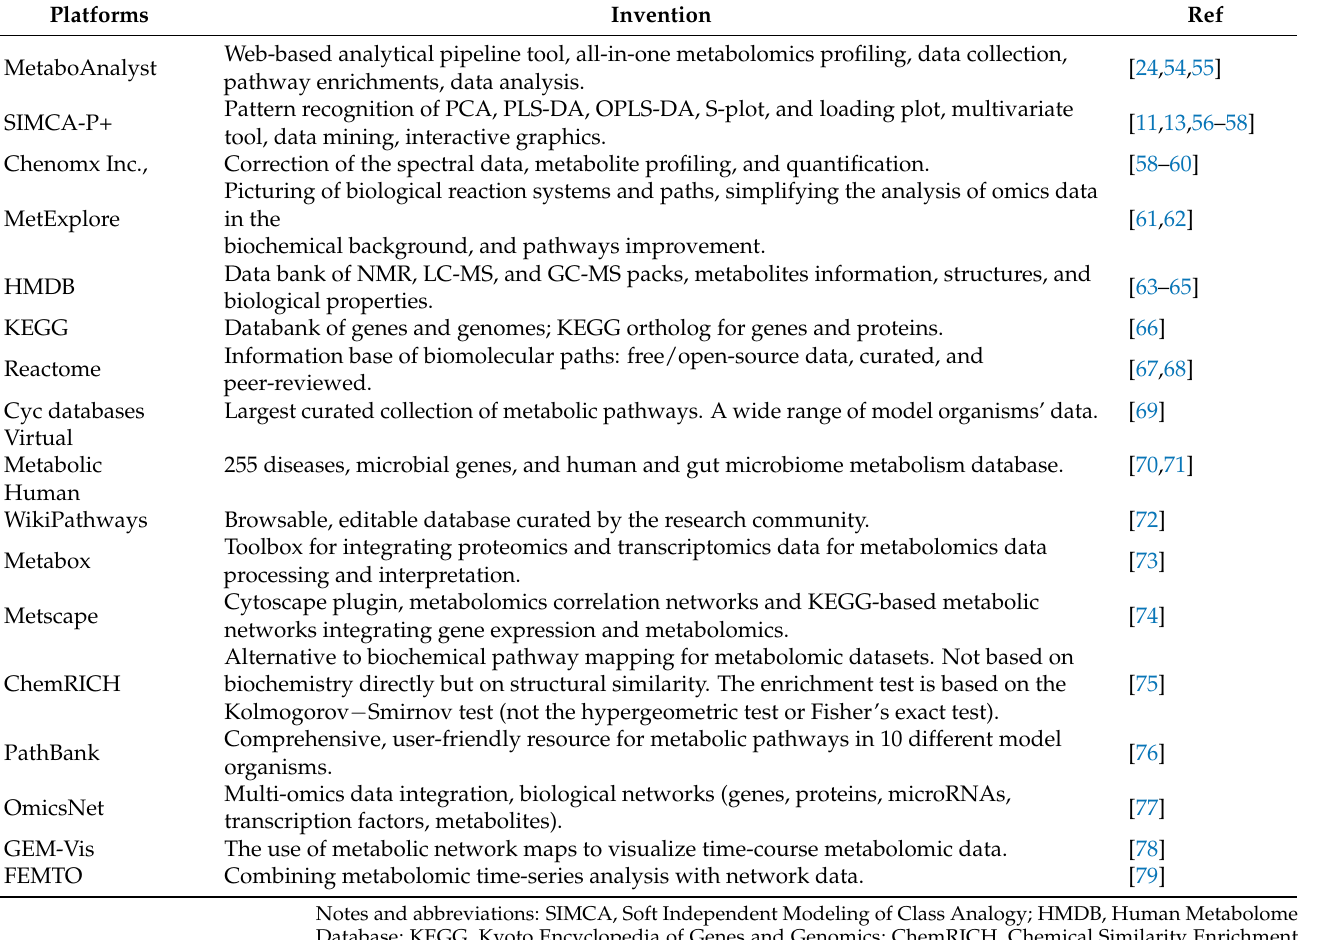
Table 2. Computational tools used for metabolomic technologies in biological